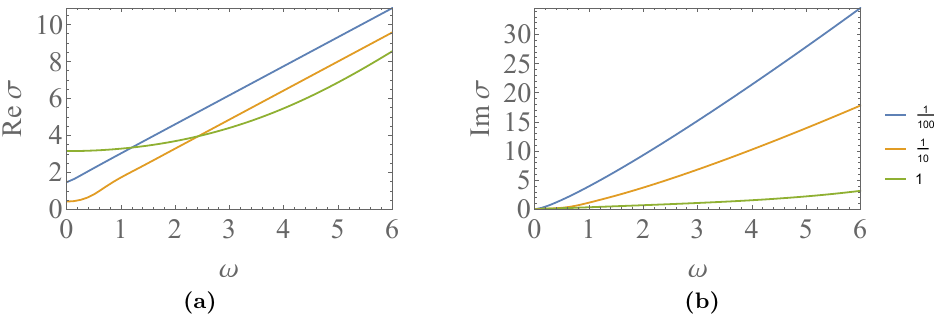
Figure 3 . The (a) real and (b) imaginary part the conductivity (cid:27) of the CFT. The legend shows the value of the temperature for both